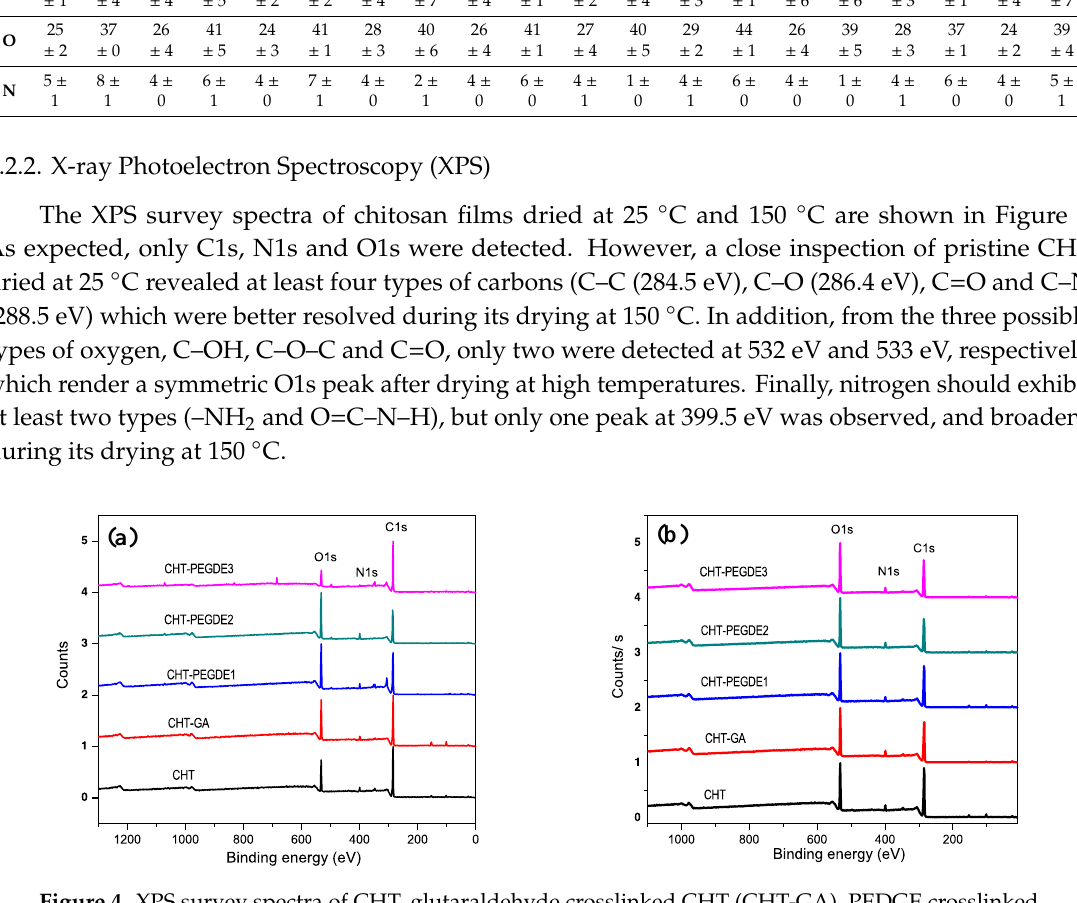
Figure 4. XPS survey spectra of CHT, glutaraldehyde crosslinked CHT (CHT-GA), PEDGE crosslinked CHT (CHT-PEDGE) at 0.114 mM (1), 0.228 mM (2) and 0.342 mM (3) dried at 25 °C ( a ) and dried at 150 °C ( b ).